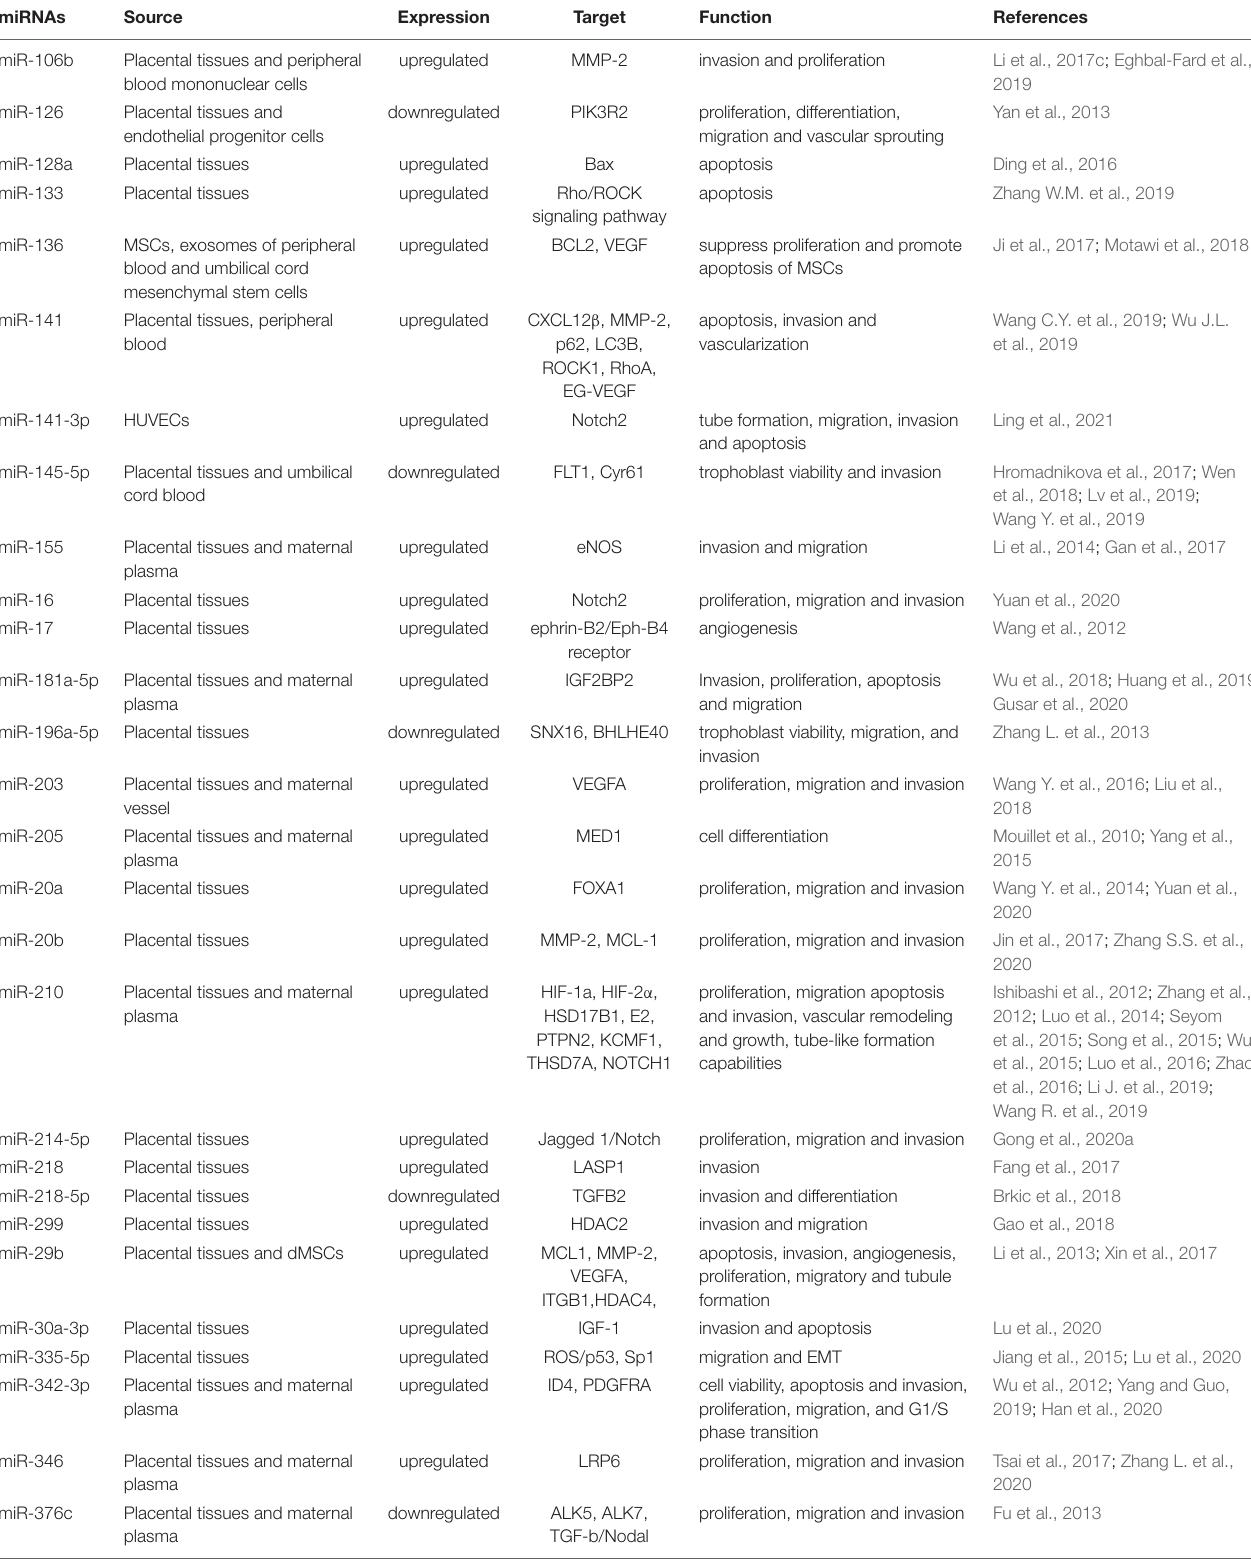
TABLE 1 | miRNAs in the pathogenesis of